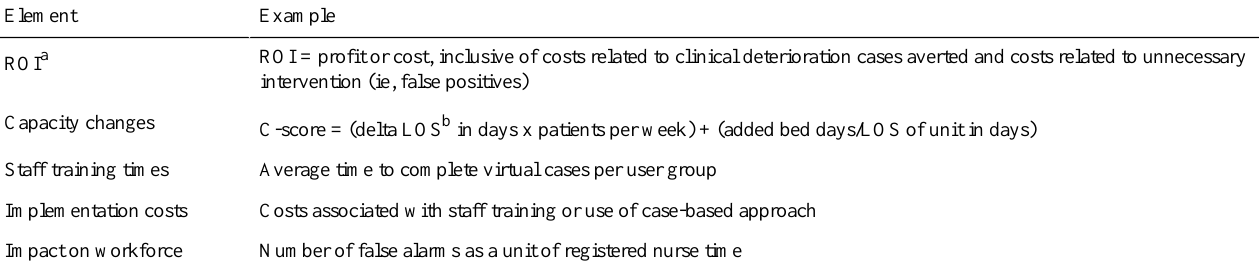
Table 1. Elements included in health system decision analysis for artificial intelligence